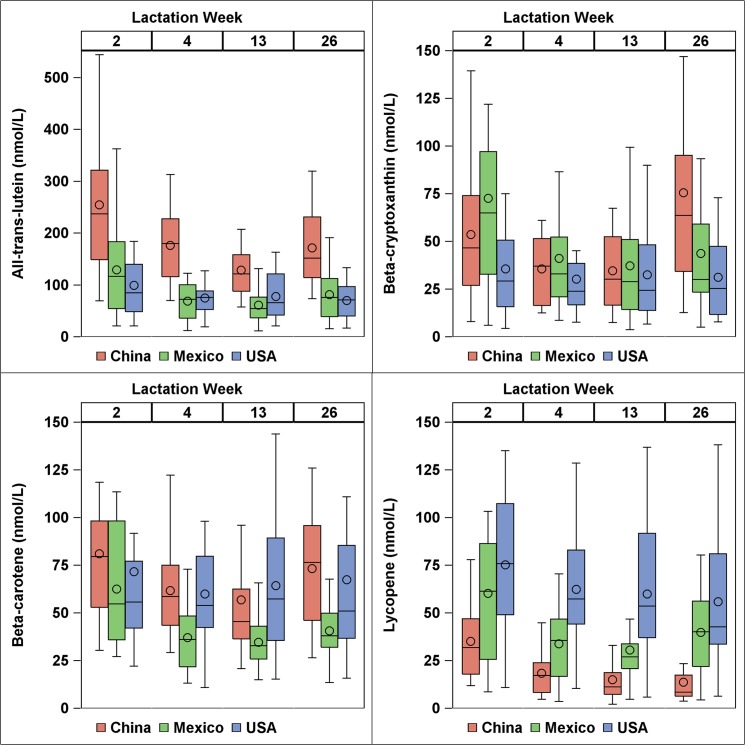
Box plots of major carotenoid species (sum of all identified cis and trans isomers) contents (nmol/L) by country and lactation stage.Boxes represent 25th, 50th, and 75th percentiles. Circle represent mean. Whiskers represent either minimum/maximum or 25th/75th minus/plus 1.5 x interquartile range, whichever is closer to the median.